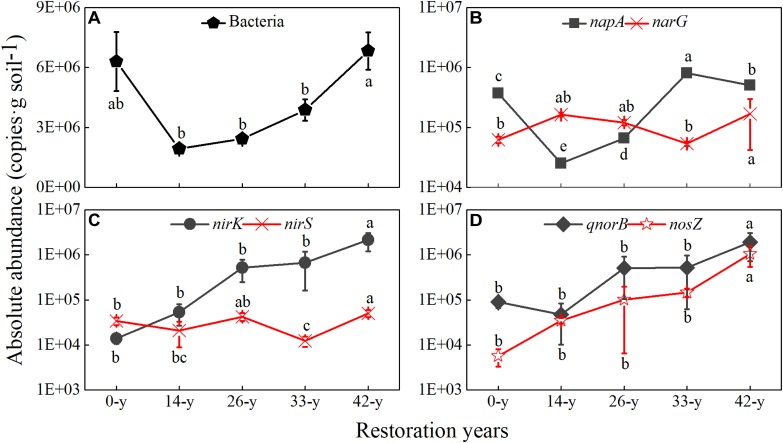
The absolute abundances of total bacteria and denitrifying functional genes among afforestation restoration of abandoned farmland. (A) Bacteria; (B)
napA, narG; (C)
nirK, nirS; (D)
qnorB, nosZ. The absolute abundances (copies g soil-1) are shown on a log 10 scale (Y-axis). The standard deviations of the three replicates are indicated by error bars. Non-visible error bars indicate that the standard deviations are smaller than the marker size. Different letters indicate significant differences (P < 0.05) among restoration ages based on a general linear model followed by an LSD post hoc test.